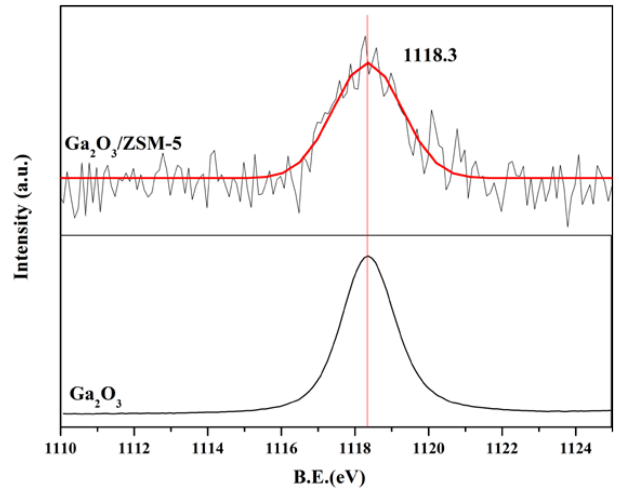
Figure 2. Ga 2p 3/2 XPS spectra of Ga 2 O 3 and Ga 2 O 3 /ZSM-5.